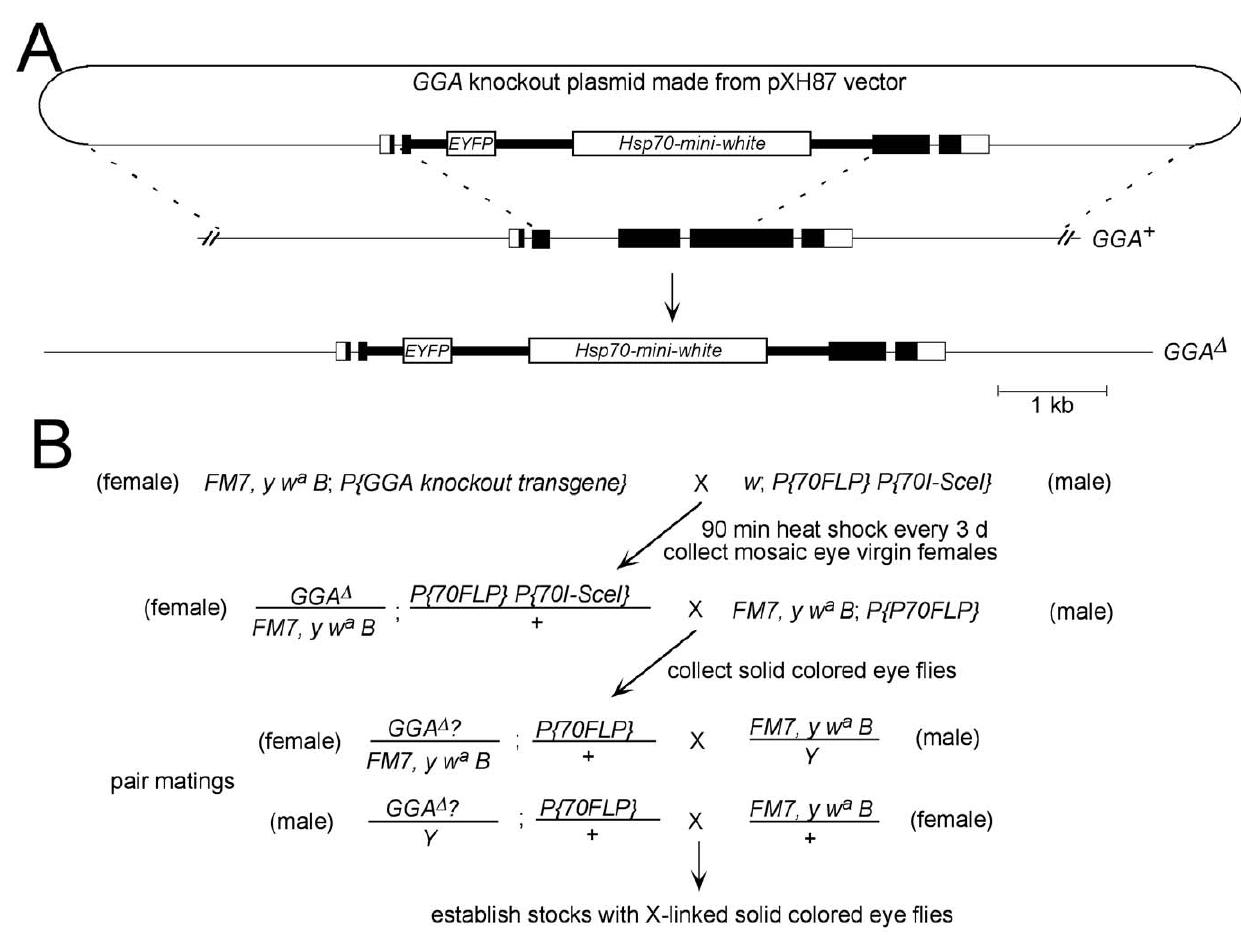
Figure 3. Generation of the GGA knockout flies. A. Molecular basis for GGA targeting. The GGA knockout plasmid was created by cloning , 3 kb GGA upstream and downstream sequences into multiple cloning sites of the pXH87 vector [35]. FLP recombinase catalyzes the excision of the knockout cassette and I-SceI cleavage releases a DNA fragment from the excised circle, which then can undergo homologous recombination with the targeted genomic DNA sequence to generate GGA D . For simplicity, the representations of the two genes to the right of GGA are omitted. B. Scheme used to generate candidate GGA D flies.